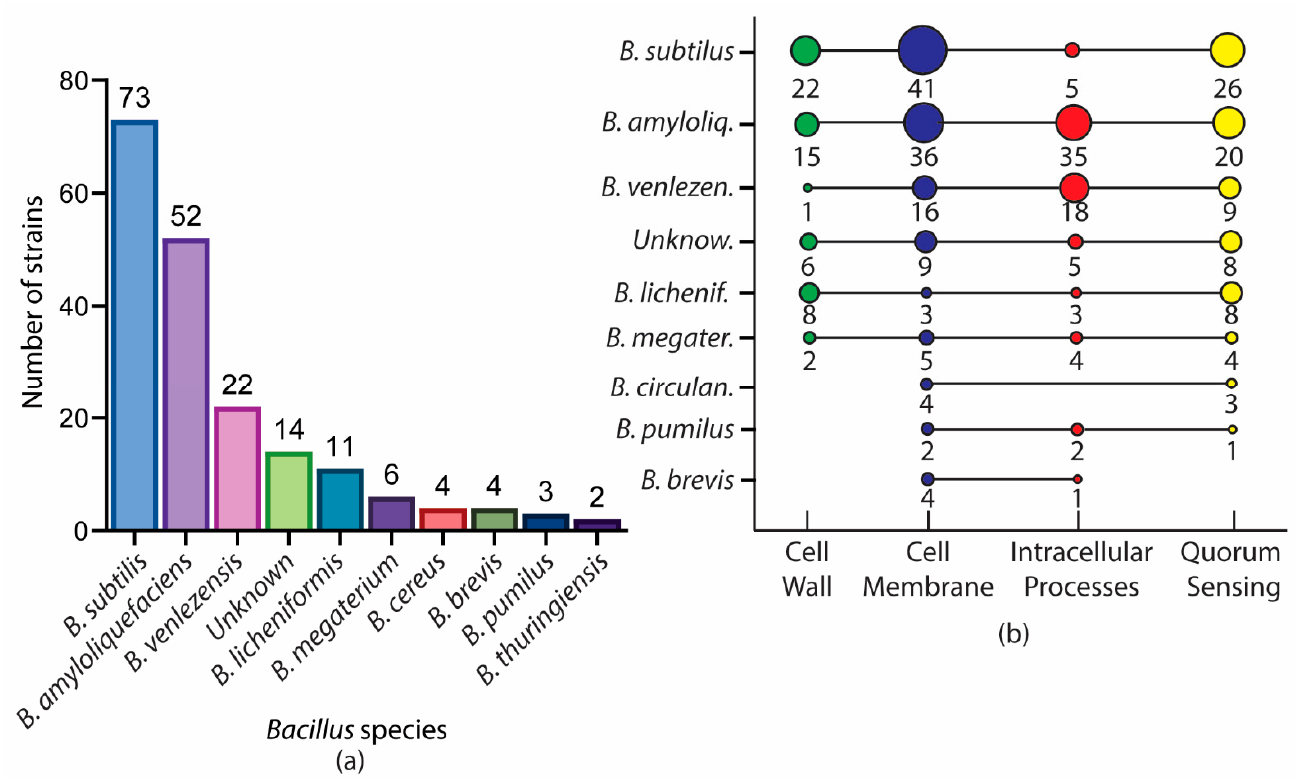
Figure 12. The analysis of ( a ) the number of strains in each species and the ( b ) mechanism of action targeted by each strain. targeted by each